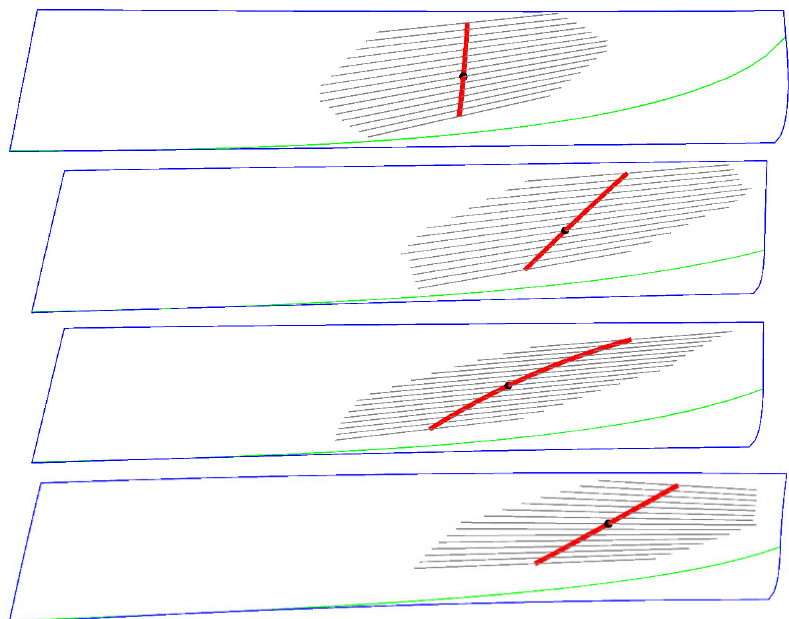
Figure 15. Contact diagrams of different helical angles (first: β = 0°; second: β = 5°; third: β = 10°; fourth: β = 21°).